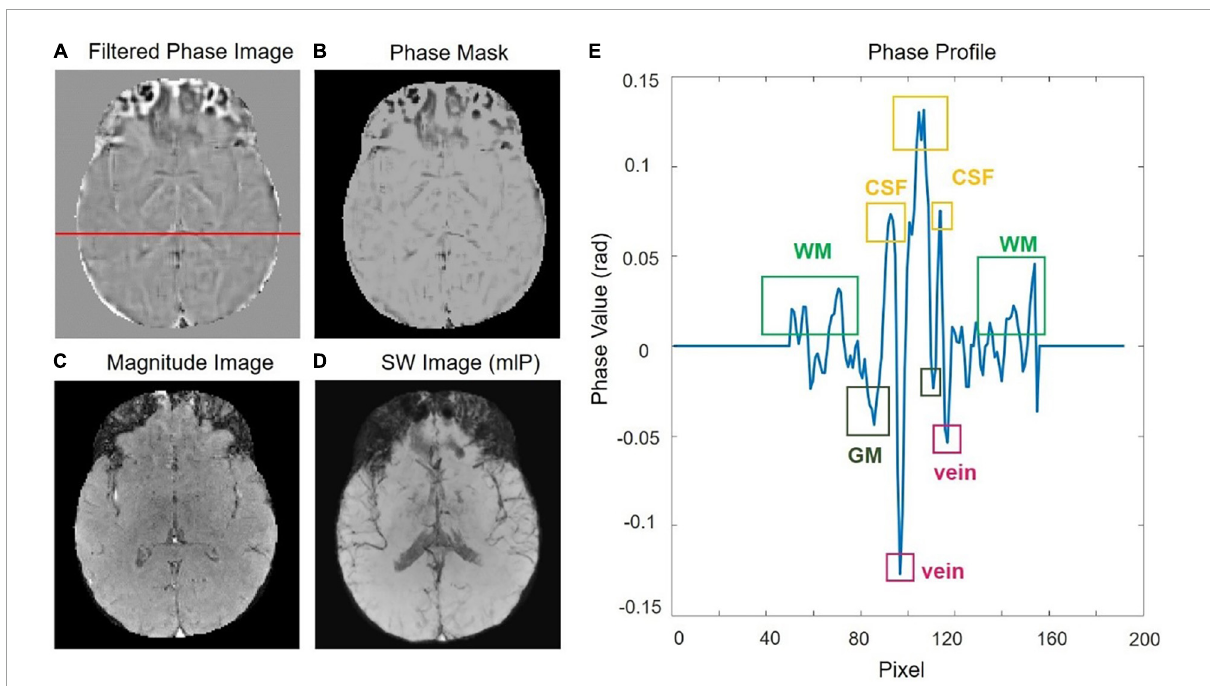
FIGURE1 (A) The original phase image was filtered with a central filter size of 64 × 64 to get the HP-filtered phase image. (B) The phase mask. (C) The raw magnitude image. (D) Susceptibility weighted imaging (SWI) image by using a minimum intensity projection. (E) Phase profile from a row of the filtered-phase image [the red line in panel (A) ].